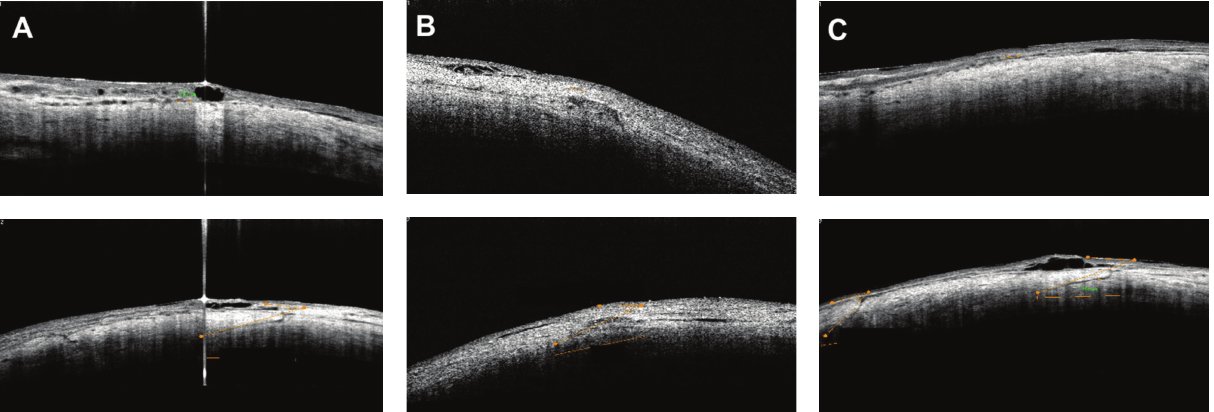
Figure 3: Spectral domain OCT images (Optovue with Cornea Camera) at the postoperative period of 25-gauge sutureless pars plana vitrectomy. (A) Longitudinal (upper) and transversal (bottom) length measurement at the sclerotomy incision, on postoperative day 1. (B) Longitudinal (upper) and transversal (bottom) length measurement at the sclerotomy incision, on postoperative day 7. (C) Longitudinal (upper) and transversal (bottom) length measurement at the sclerotomy incision, on postoperative day 30.